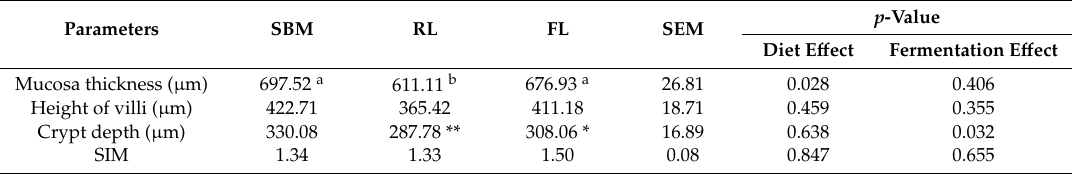
Table 7. Morphometric parameters of